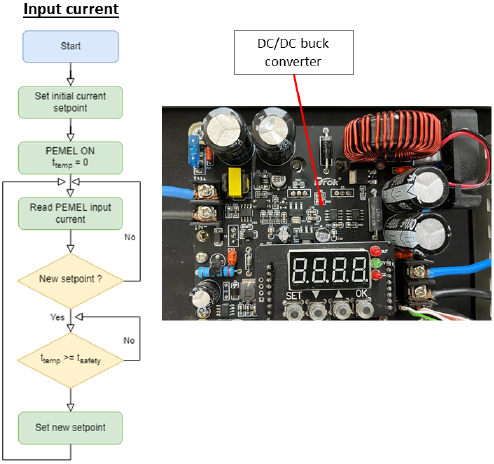
Figure 5. Control algorithms for the PEMEL input current and the related DC/DC converter.